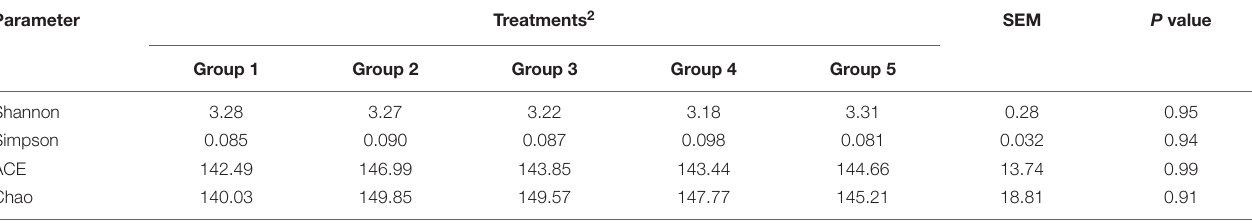
TABLE 6 | The parameters of α diversity of cecal microbiota in different groups 1 . Parameter